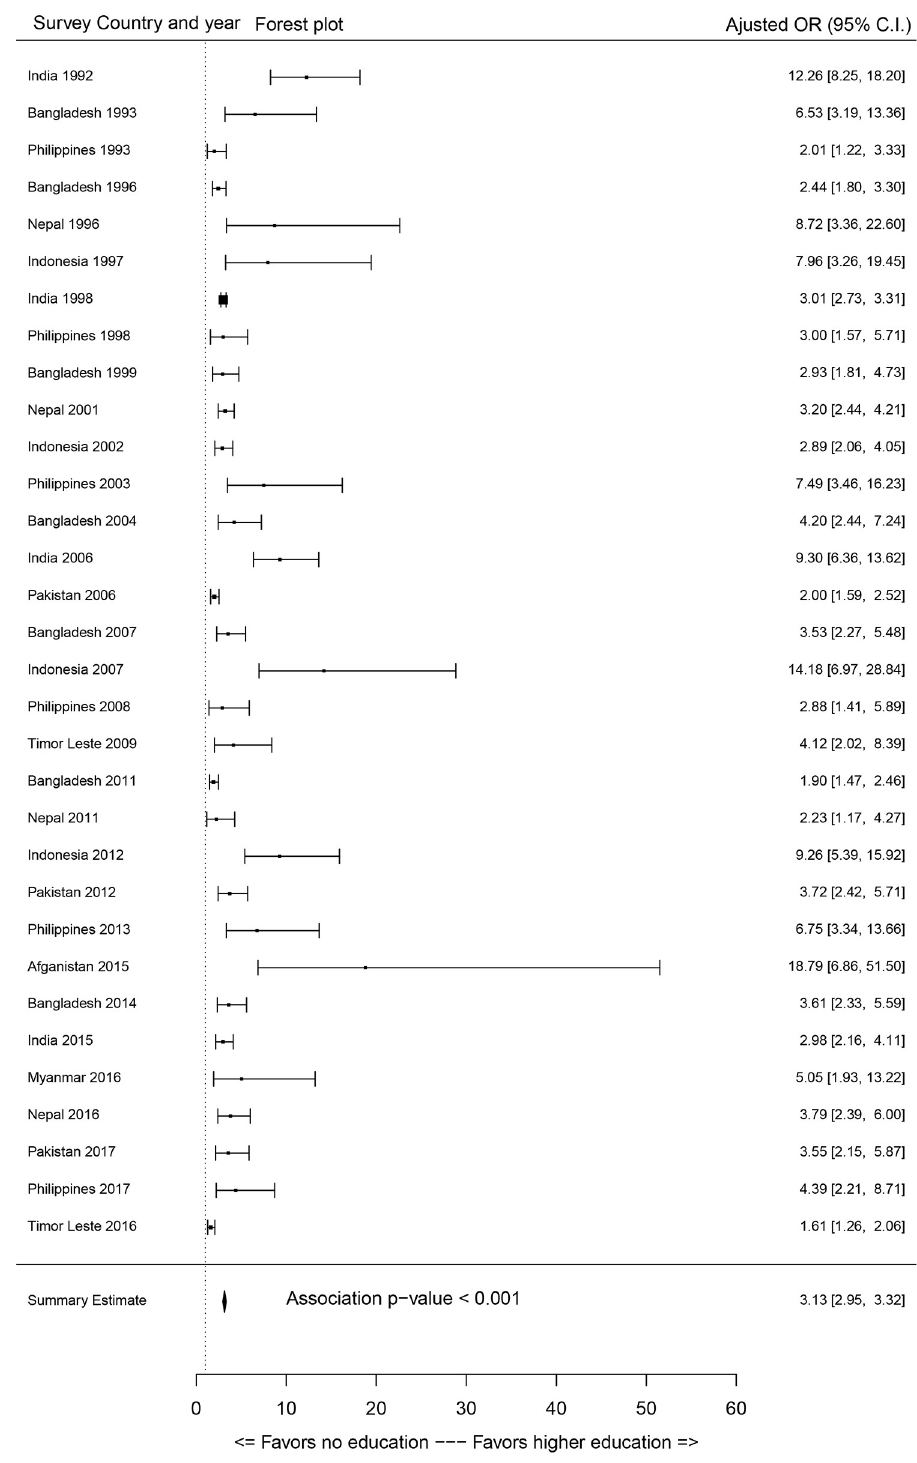
Fig 4. Forest plot of odds of women having higher education on access to skilled birth attendants compared to women with no education (OR = odds ratio, C.I. = confidence interval).